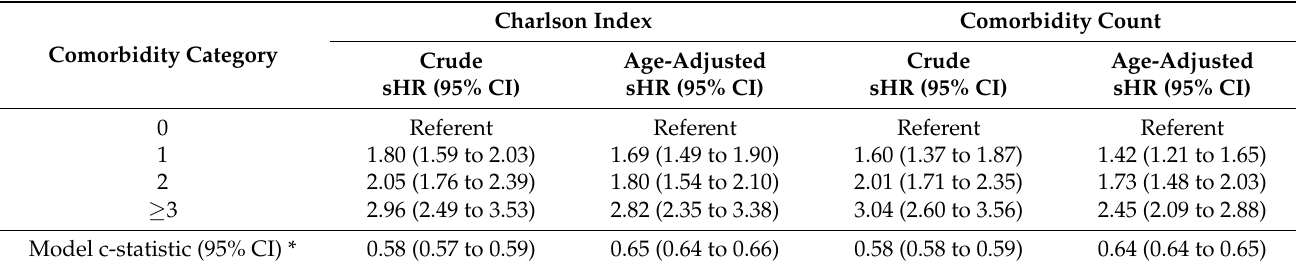
Table 3. Crude and age-adjusted subdistribution hazard ratios for 5-year other-cause mortality by Charlson index and comorbidity count and corresponding model